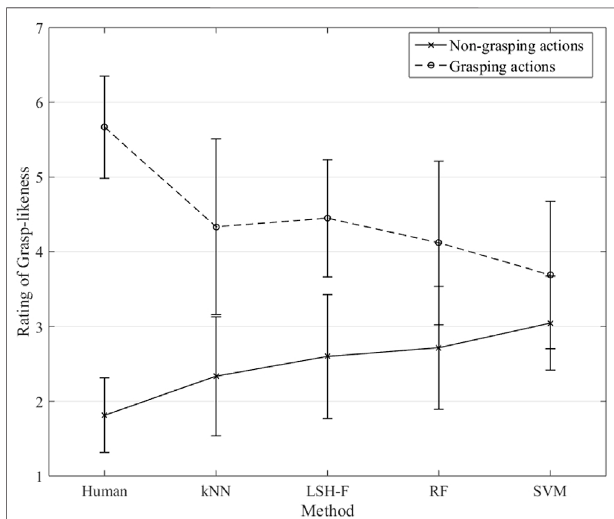
FIGURE 4 | Rating means for grasping and non-grasping gestures for humans and ML techniques (Error bars represent 95% CI.).